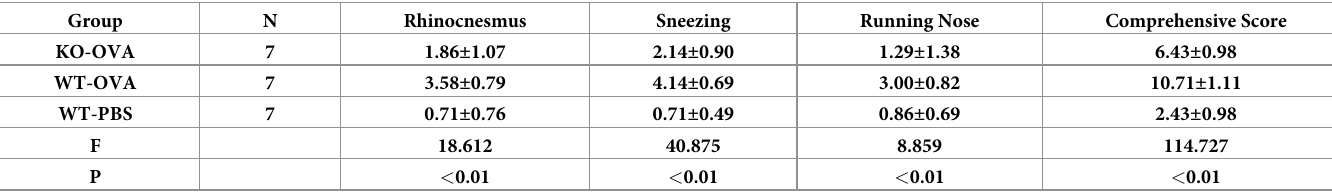
Table 1. The average score of allergic rhinitis symptoms in mice ( � x � s ).